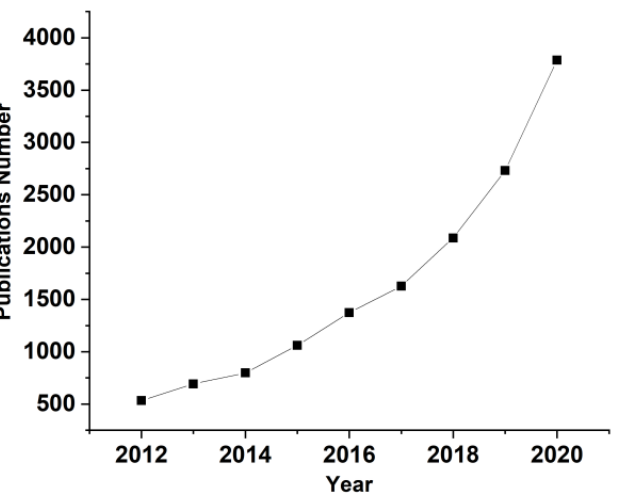
Figure 1. Annual number of publications about “Metals doped PVA” over the last decade in the fields of physical and chemical sciences (source of information: ReadCube- www.readcube.com, accessed on 30 March 2016).